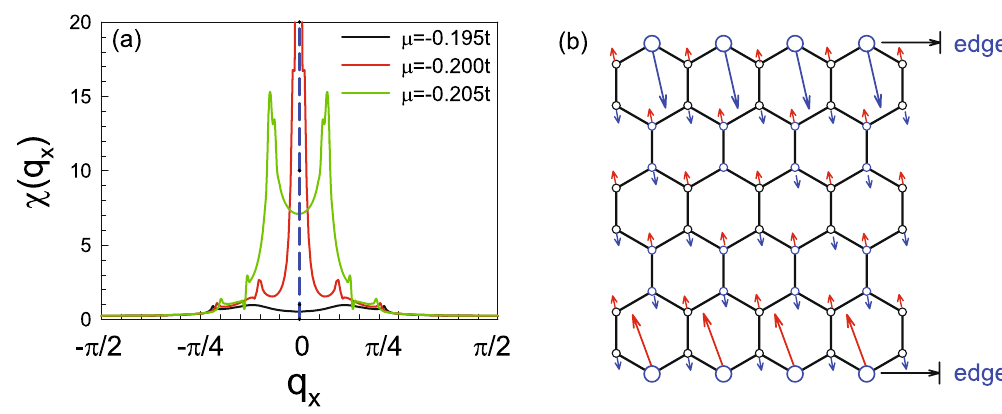
,(0) Figure 4. ( a ) The largest eigenvalue χ ( q x ) of the susceptibility matrix χ q ( ) l m x as a function of q x for three different dopings, i.e., μ = − 0.195 t ( δ = 3.6%), μ = − 0.2 t ( δ = 3.0%) and μ = − 0.205 t ( δ = 0.8%) for the 6-chain system near half-filling. ( b ) Sketch of the pattern of the dominating spin fluctuations for μ = − 0.2 t , as ,(0) corresponding to its largest determined by the eigenvector of χ = q ( 0) l m x